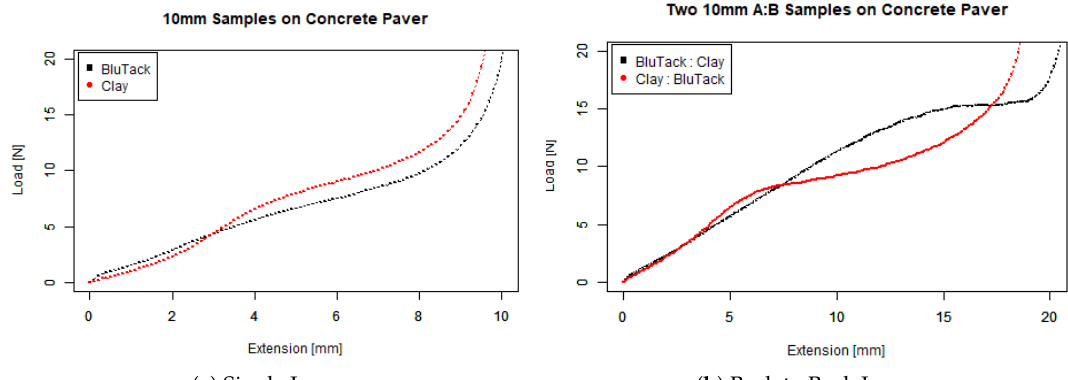
Figure 13. Instron 5980 testing soft layers on concrete.